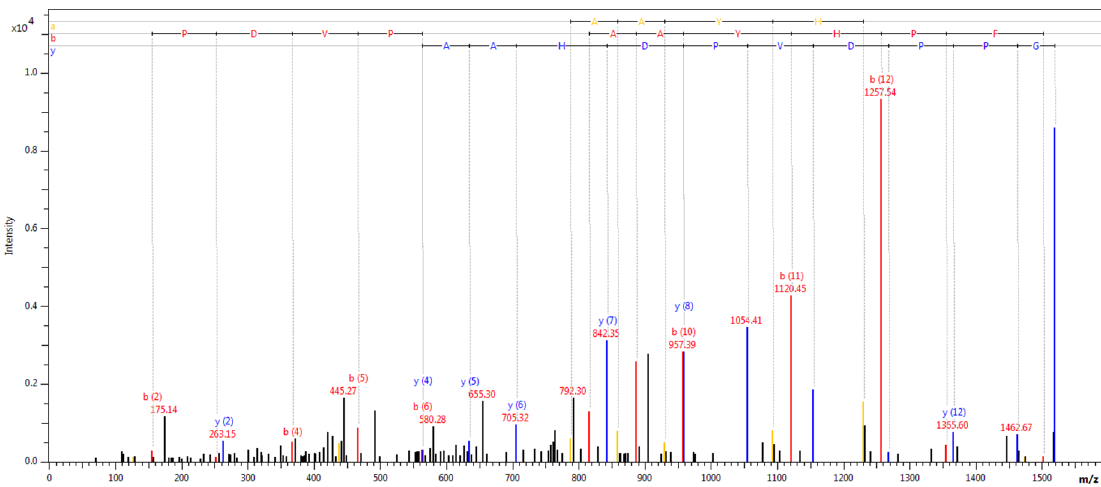
Figure 3. Fragmentation spectrum of peak 1519.99, identified as complement C3.